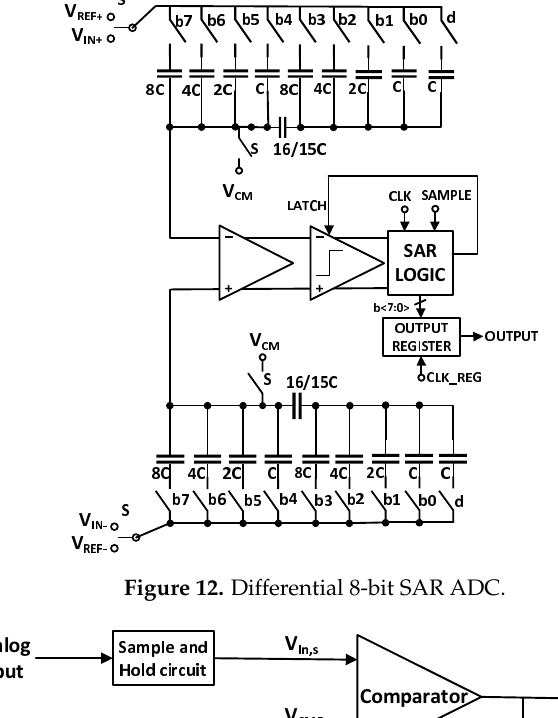
Figure 12. Differential 8-bit SAR ADC.